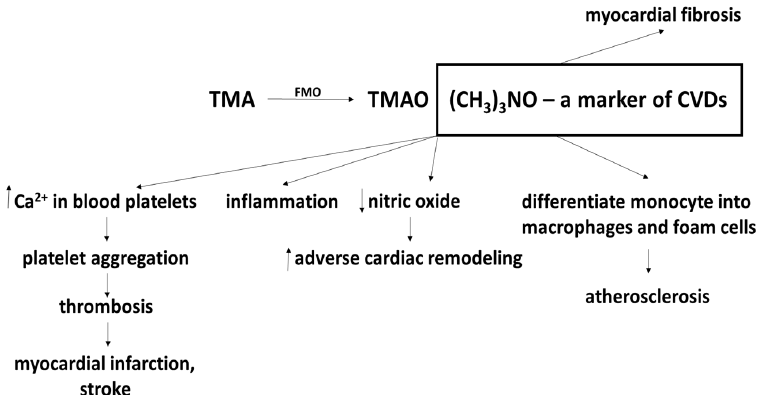
Figure 1. Effect of trimethylamine-N-oxide (TMAO) on cardiovascular diseases (CVDs) (modified )[71] More details in text.